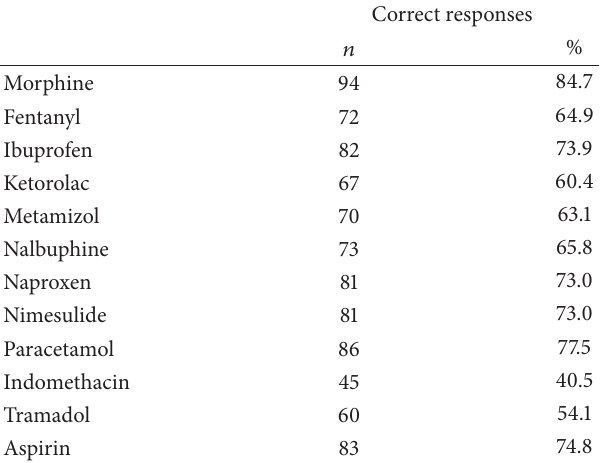
Table 4: Knowledge of hospital nurses about which of the following drugs is or is not opioid or